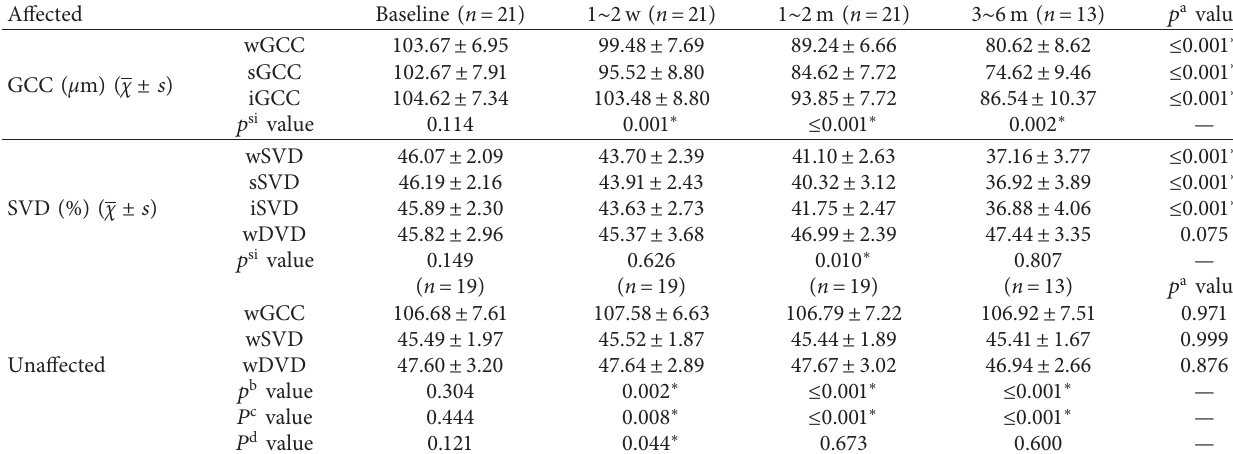
Table 2: OCT and OCT-A parameters in the macular retina in affected eyes of NAION.